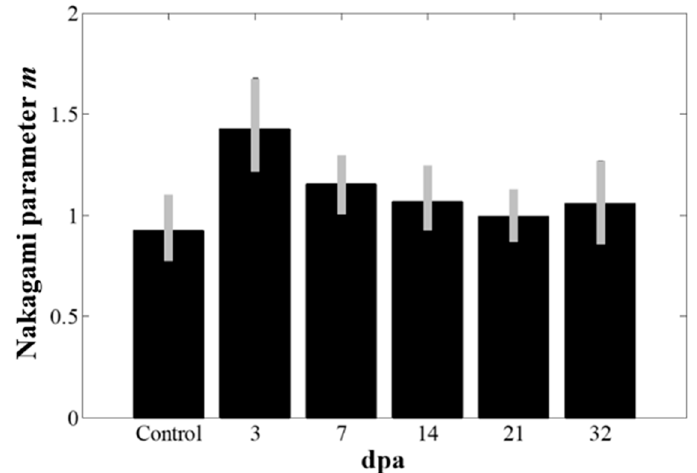
Figure 7. The changes of the Nakagami parameter m values before and after amputation. The Nakagami parameter value significantly increased at 3 dpa ( p -value < 0.05) and recovered to the value before amputation. The error bars indicate the standard deviation in the data from five zebrafish.